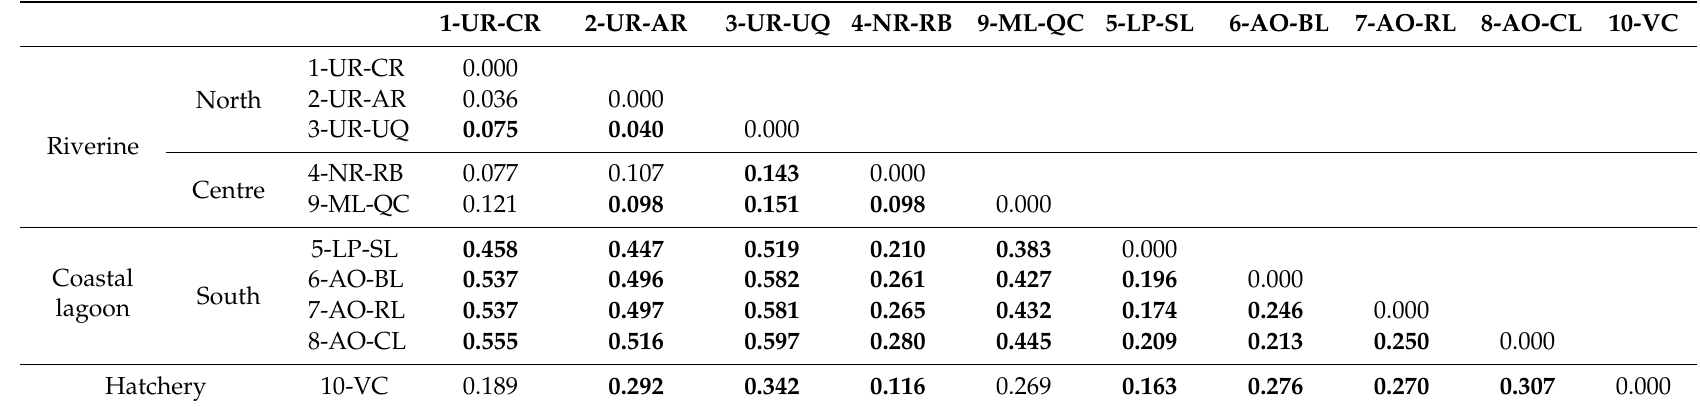
Table 4. Pairwise F ST values between localities based on the Total dataset of 17,559 SNP loci. Significant FST values are highlighted in bold type ( p < 0.05).